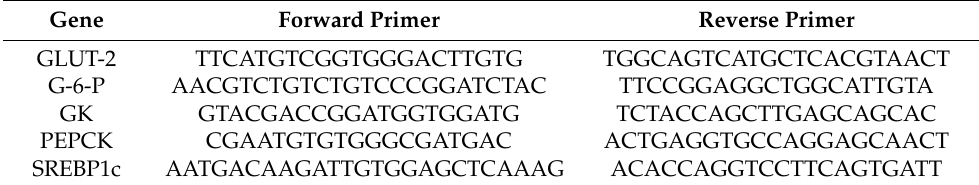
Table 2. Primer sequences uded in the